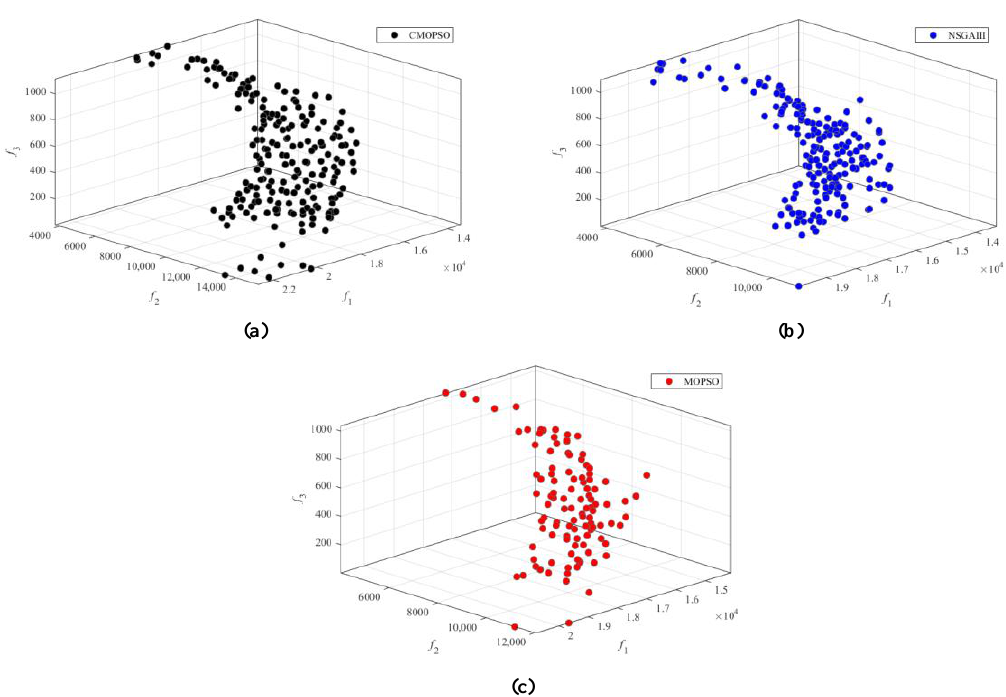
Figure 12. Comparison of Pareto optimal solution distribution: ( a ) CMOPSO ( b ) NSGA-III ( c ) MOPSO. Table 6. Algorithm performance comparison (CMOPSO, NSGA-III, MOPSO).